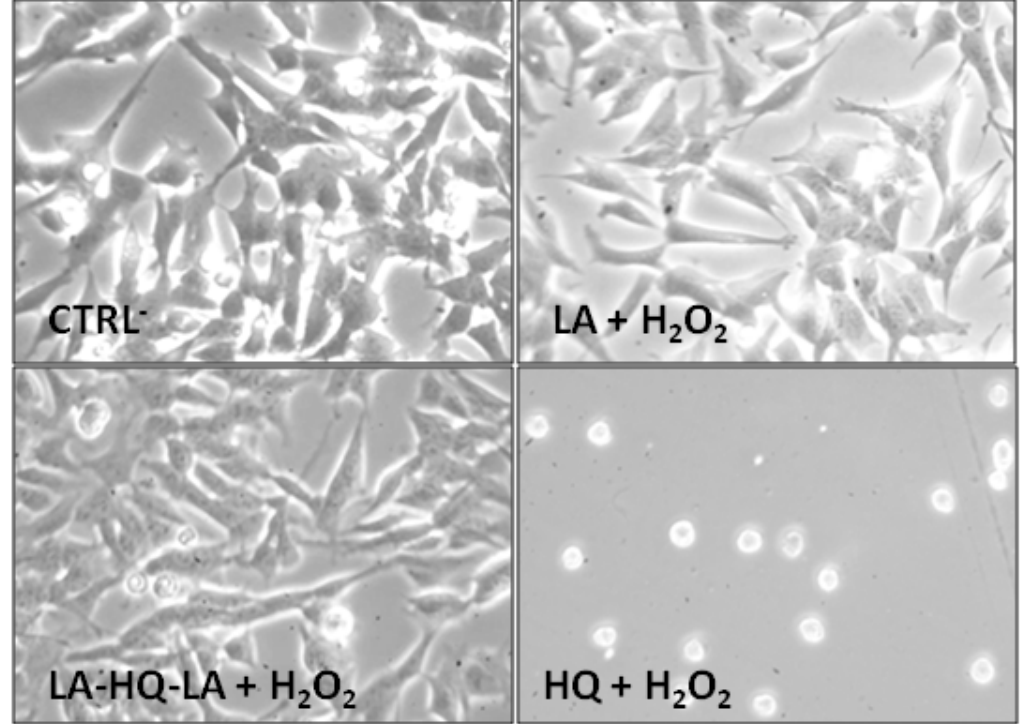
Figure 4. Morphological analysis of undifferentiated and H neuroblastoma cells in the presence of LA, LA-HQ-LA, and HQ. a